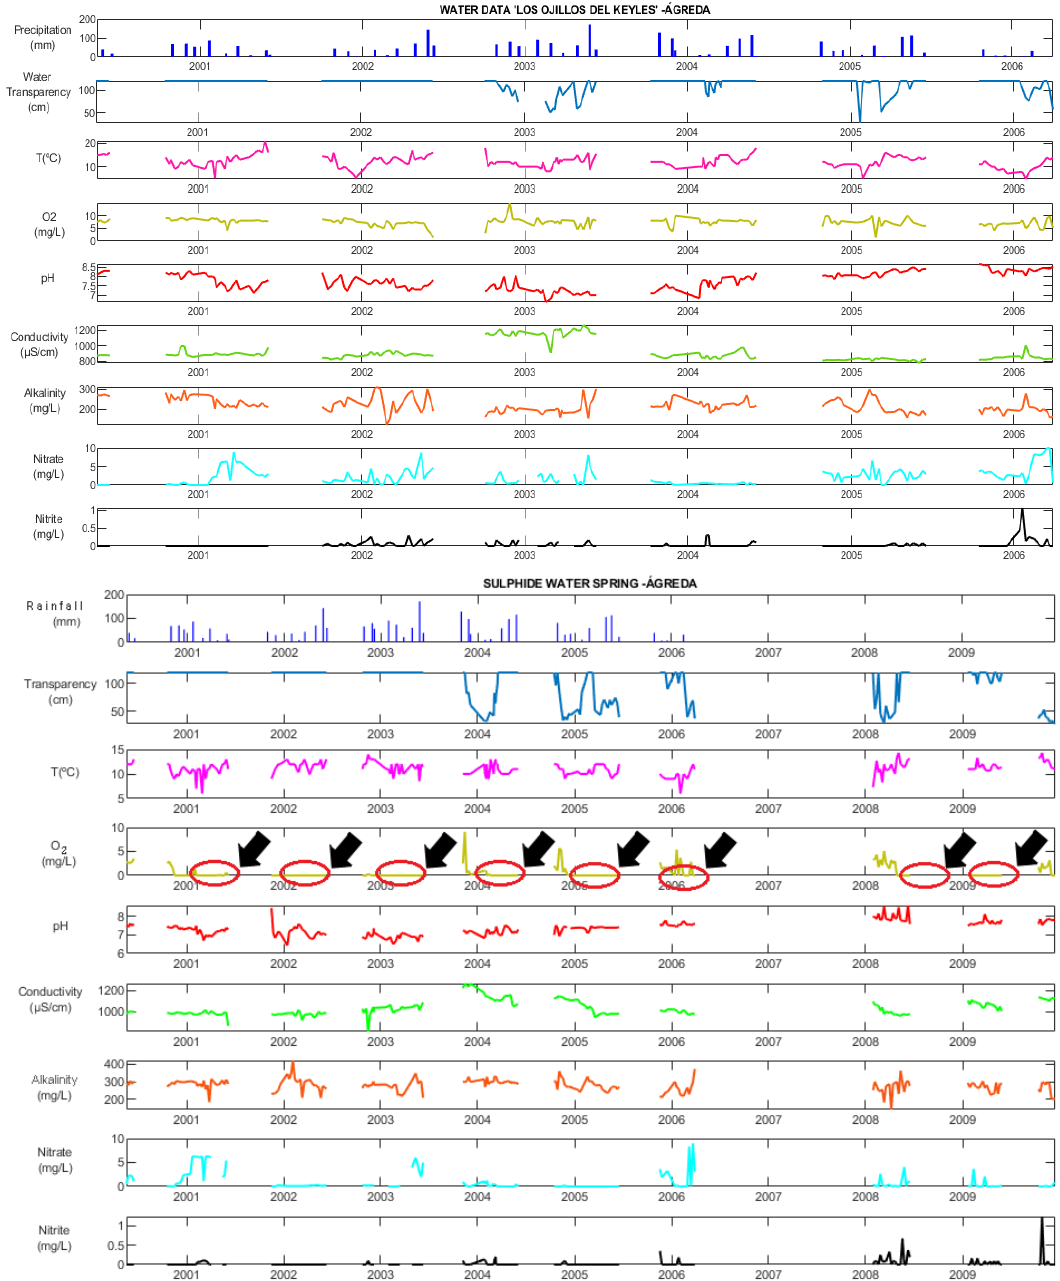
Figure 5. Variation of physical and chemical parameters of Los Ojillos del Keyles and Á greda sulphide springs during 2001–2009.